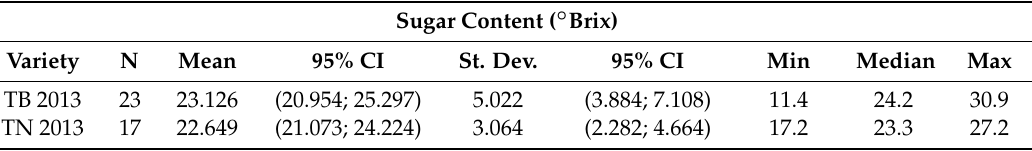
Table A12. Descriptive statistics of the samples used in the external test sets to further study the generalization capacity for the prediction of the sugar